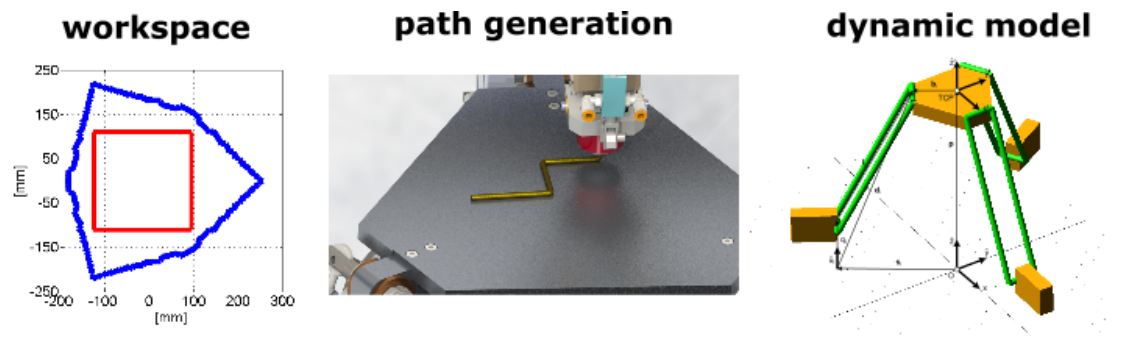
Figure 8. Evaluation of the process through a dynamic model.